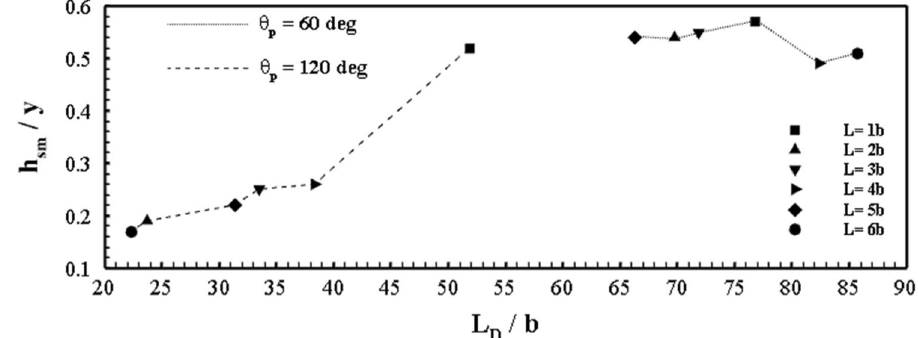
Fig. 13 The height of maximum sedimentation against the length of sediment progress toward the downstream of piers and collar installed at the 60- and 120-degree